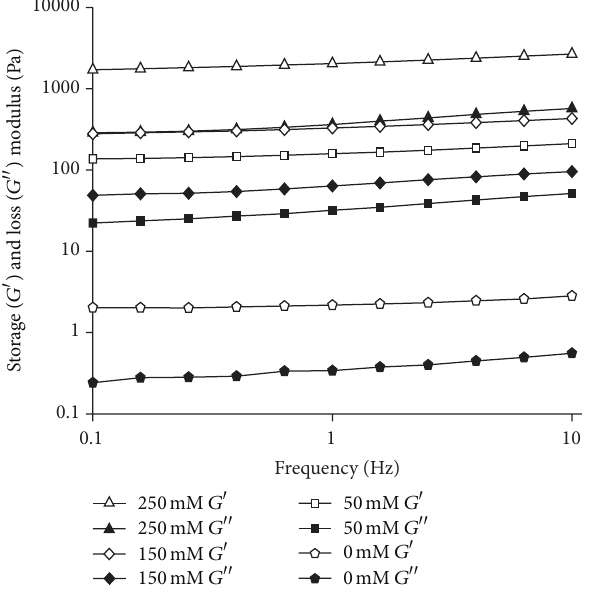
Figure 7: Frequency dependence of storage (𝐺 󸀠 ) and loss (𝐺 󸀠󸀠 ) modulus of 5% LP with different content of Ca 2+